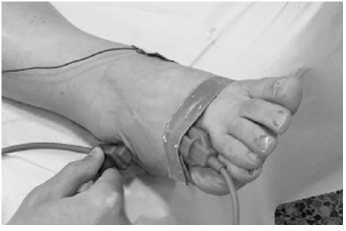
Figure 2. Nerve conduction study of the dorsal sural nerve.